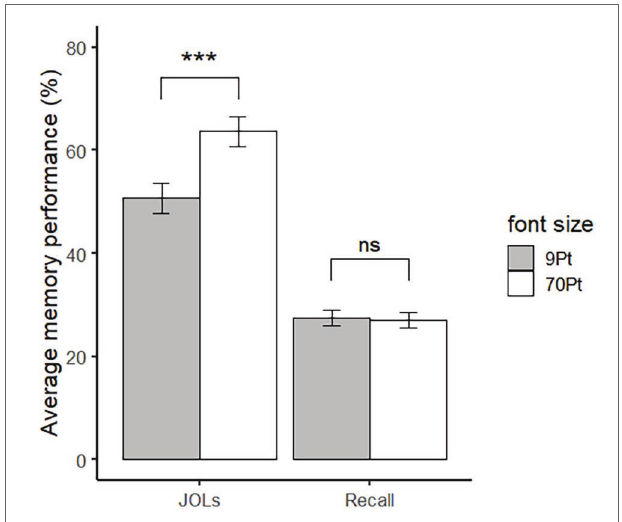
FIGURE 1 | JOLs and recall for large and small words in Experiment 1. Error bar represents ±1 standard error. ∗∗∗ p < 0.001.